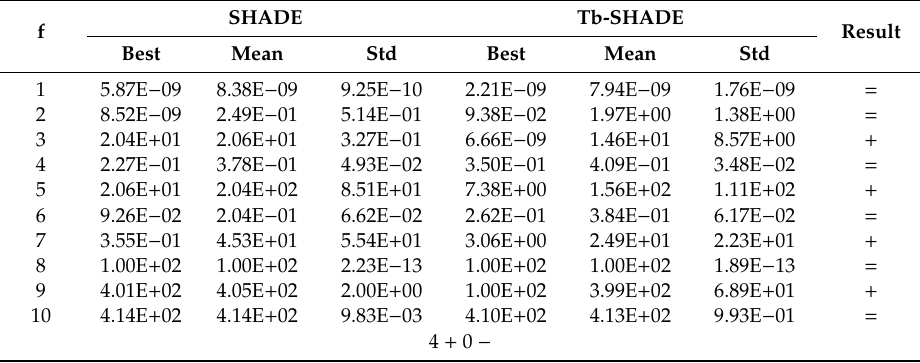
Table 10. SHADE vs. Tb-SHADE on CEC2020 in 20 D .